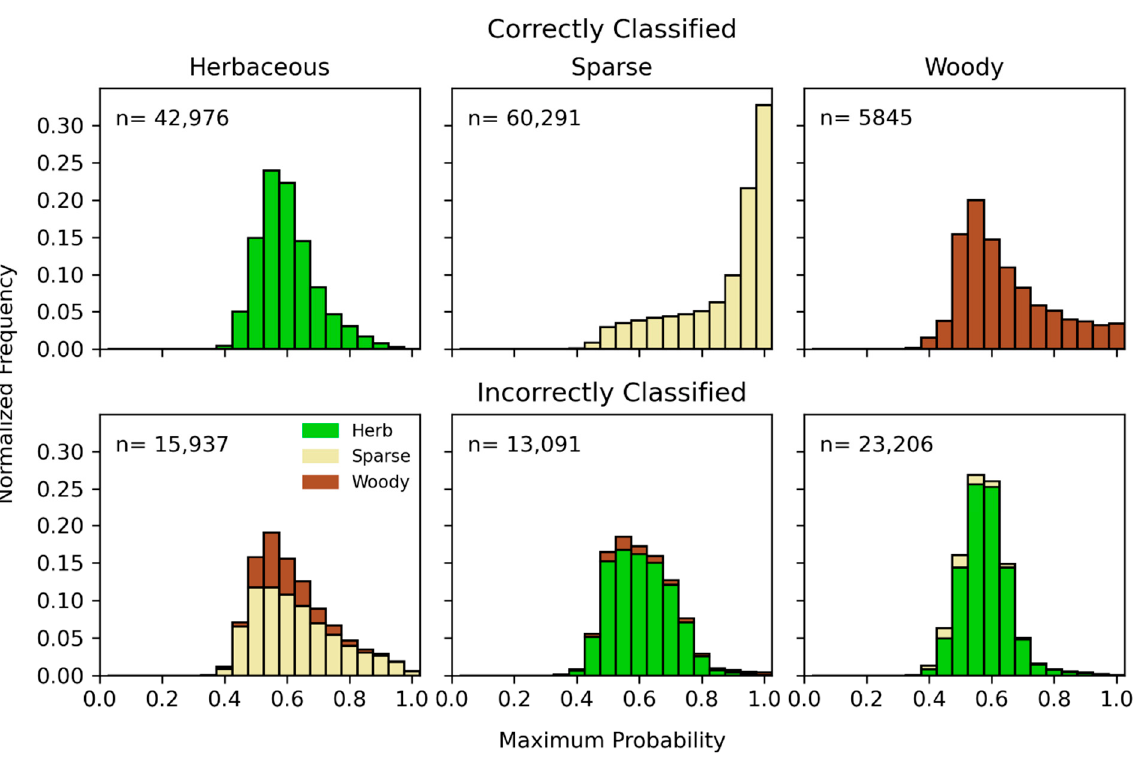
Figure 5. Distribution of maximum probabilities of correctly classified cells (top row) and incorrectly classified cells (bottom row) by habitat (columns).